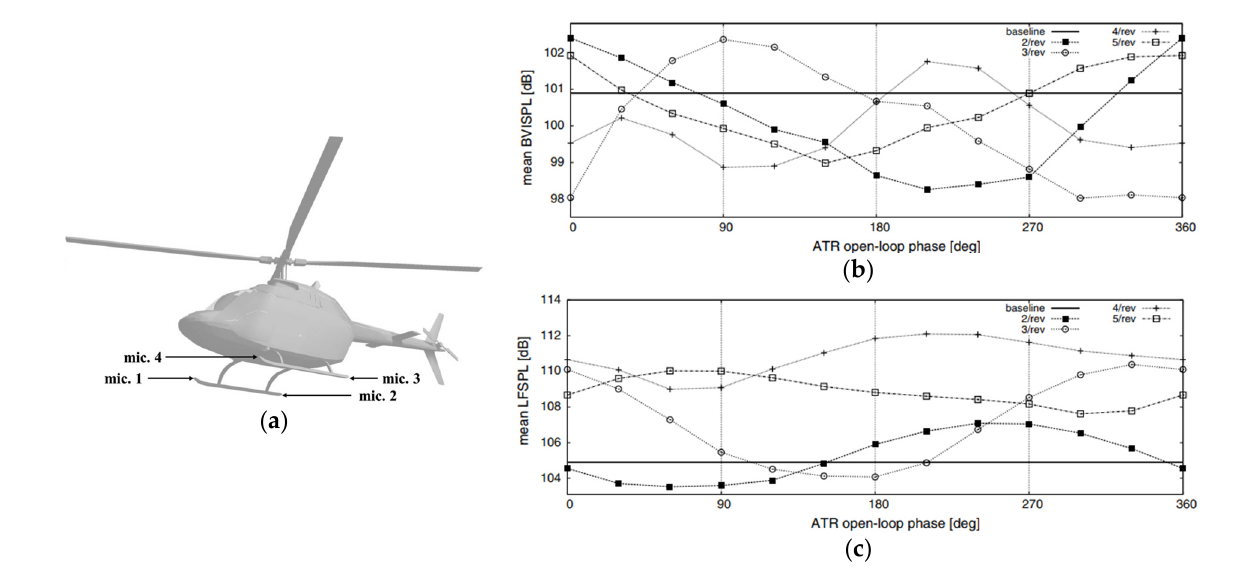
Figure 8. ( a ). Location of microphones; ( b ). Mean BVI sound pressure level for open-loop controller; ( c ). Mean Low-frequency Sound Pressure Level [48]. Reprinted with permission from Anobile, A. (2016).